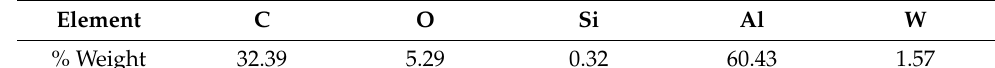
Table 6. Elemental composition of the tool at the yellow cross in Figure 6.